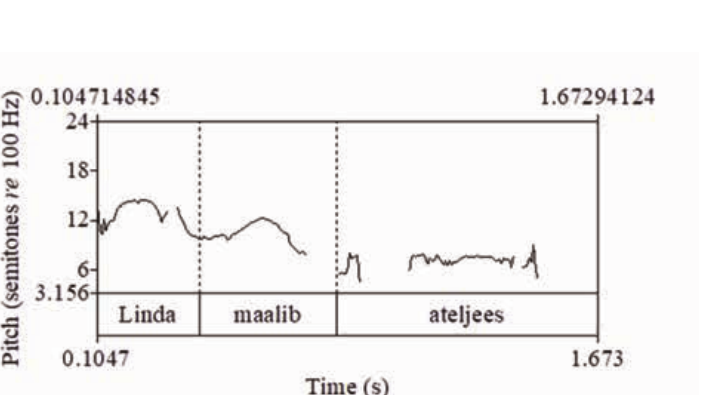
Figure 2: The pitch contour of the sentence in (11), produced in a broad focus context (from Sahkai and Veismann